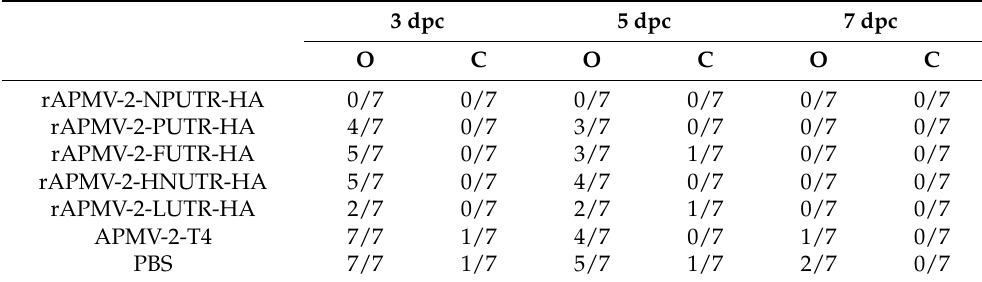
Table 3. Virus shedding of chickens challenged with H9N2